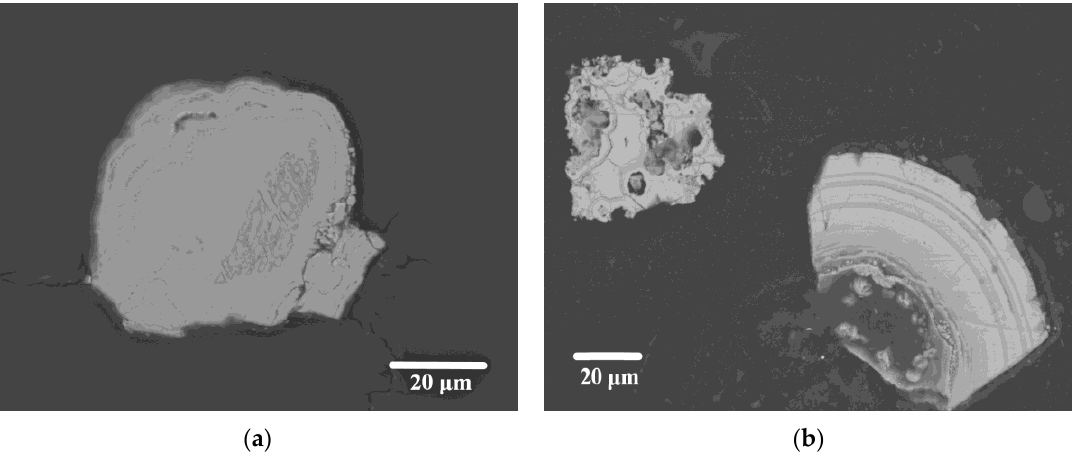
Figure 3. Aggregates of amgaite. Polished section. SEM (BSE) images. ( a ) botryoidal aggregate ( b ) fragments of colloform aggregates.